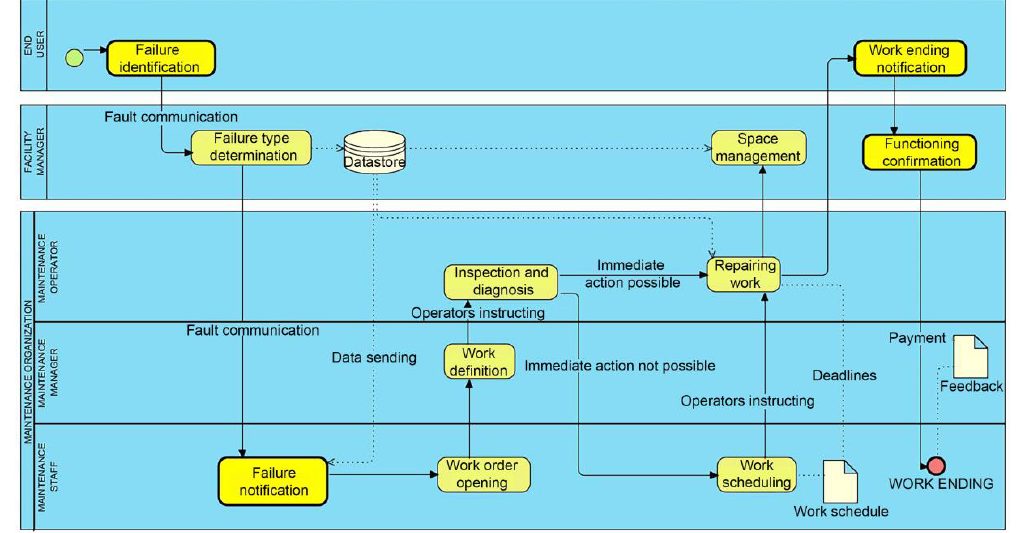
Figure 2. Corrective maintenance workflows, flowchart-type.